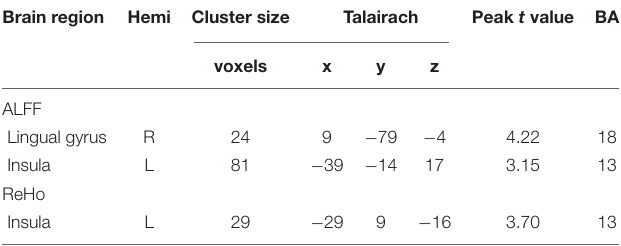
TABLE 7 | ALFF and ReHo changes in patients with MMoA after SA. Brain region Hemi Cluster size